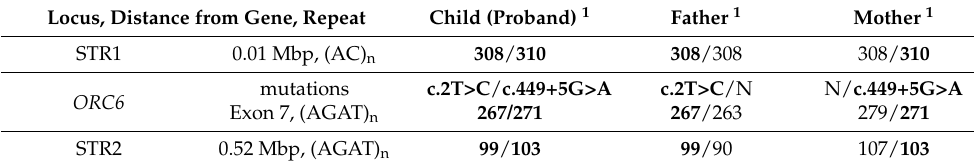
Table 1. Family haplotypes of STRs linked to the ORC6 gene. Locus, Distance from Gene, Repeat Child (Proband) 1 Father 1 Mother 1 STR1